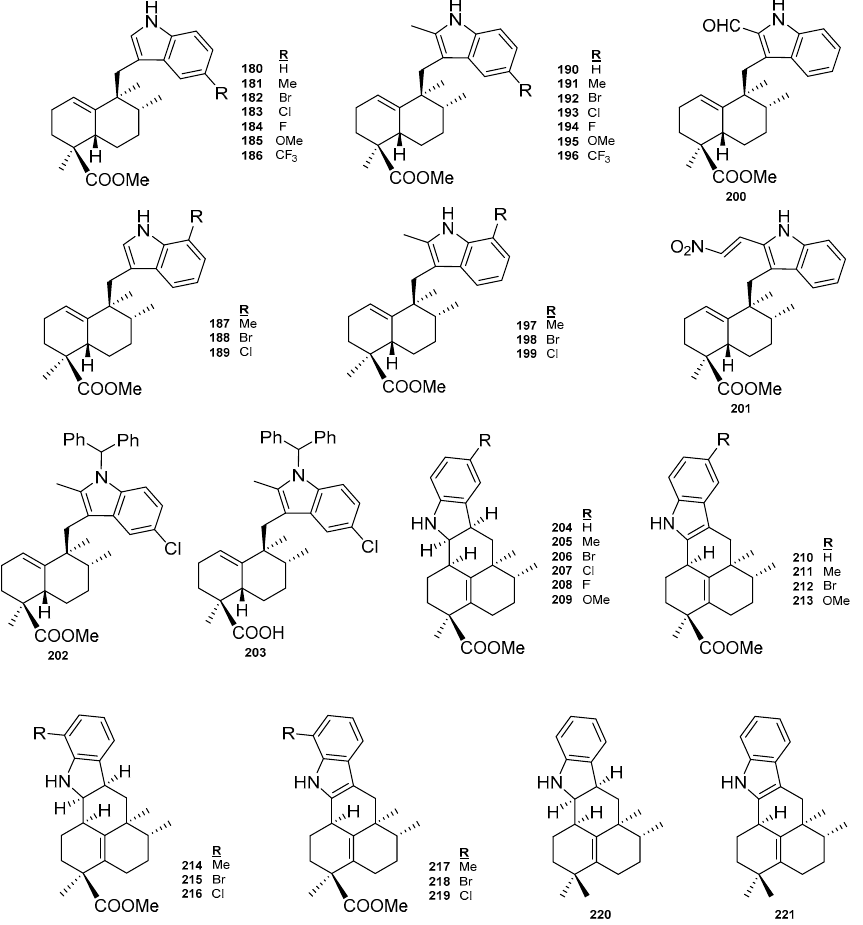
Figure 12. Sesquiterpenylindoles synthesized from 2 .